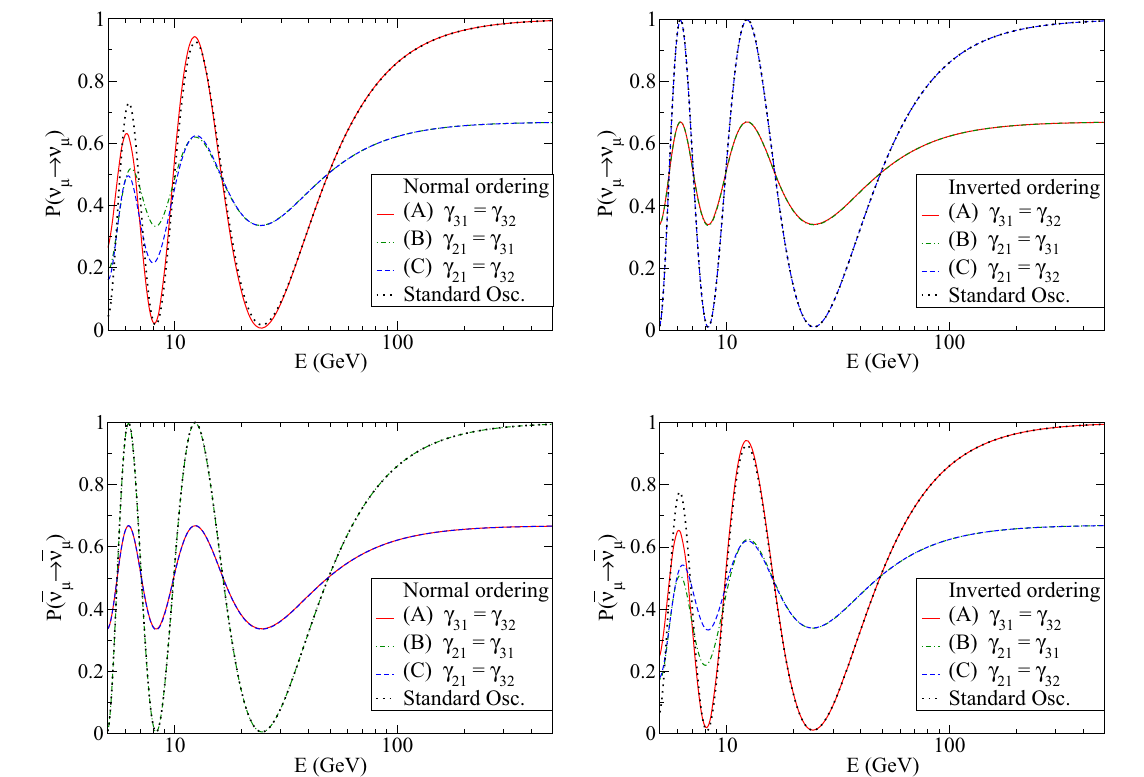
Fig. 1 The ν μ → ν μ (top panels) and ν μ → ν μ (bottom panels) oscillation probabilities with ( n = 0) and without decoherence effects as a function of the neutrino energy. The probabilities have been com- puted for normal (left panels) and inverted (right panels) neutrino mass ordering, using a three-layer model for the Earth matter density pro-